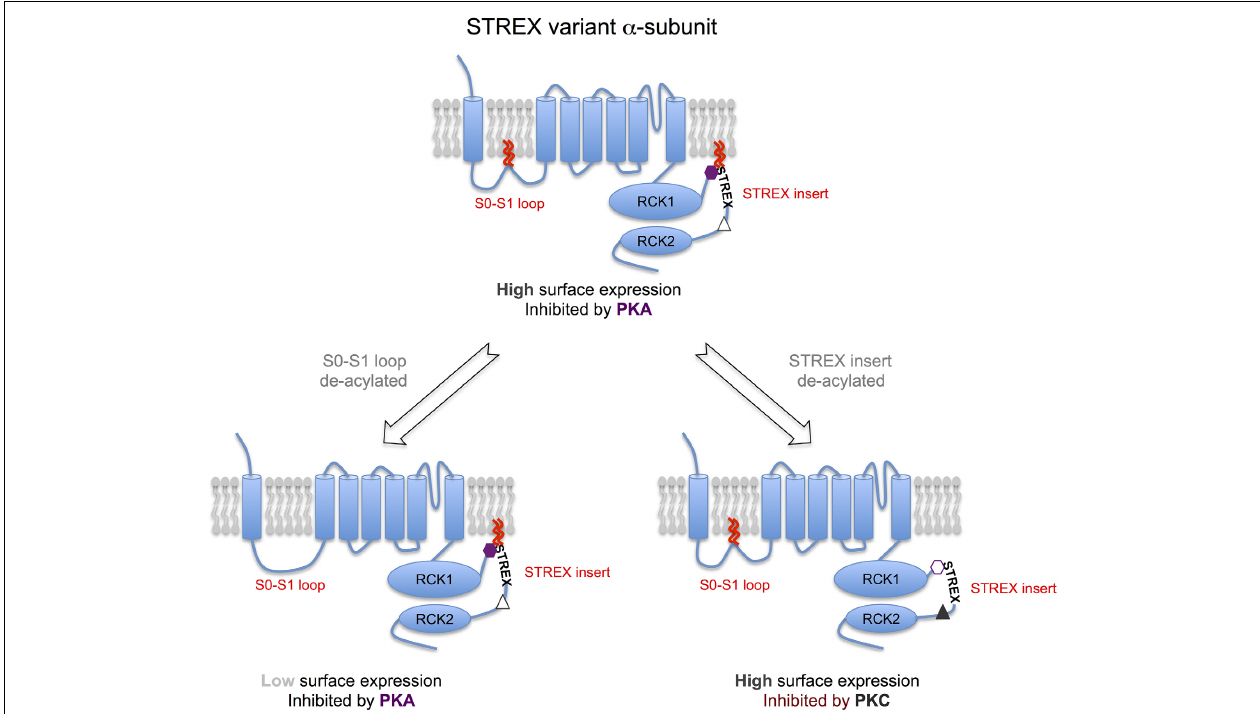
FIGURE 2 | S-acylation of the α -subunit controls distinct properties of BK channels. Model schema for regulation of STREX variant α -subunits by S-acylation and AGC-family kinases. The STREX variant of the BK channel can be S-acylated at two distinct sites: (i) the S0-S1 loop allowing the loop to associate with the plasma membrane and is important in controlling surface delivery of the BK channel; (ii) in the alternatively spliced STREX insert that allows the cytosolic STREX domain to interact with the plasma membrane. S-acylation of the STREX insert determines STREX channel regulation by AGC-family protein kinase dependent phosphorylation. Protein kinase A (PKA)-dependent phosphorylation of S 636 in the STREX insert (purple hexagon), that is immediately upstream of the S-acylated cysteine residues, results in dissociation of the STREX domain from the plasma membrane and inhibition of STREX channel activity. In contrast, when STREX is S-acylated, protein kinase C (PKC) has no effect on channel activity even though phosphorylation of the PKC-consensus sites (S 700 and S 1156 ), that are downstream of the STREX insert, result in channel inhibition in channels lacking the STREX insert (e.g., ZERO variant). Thus, the S-acylated STREX